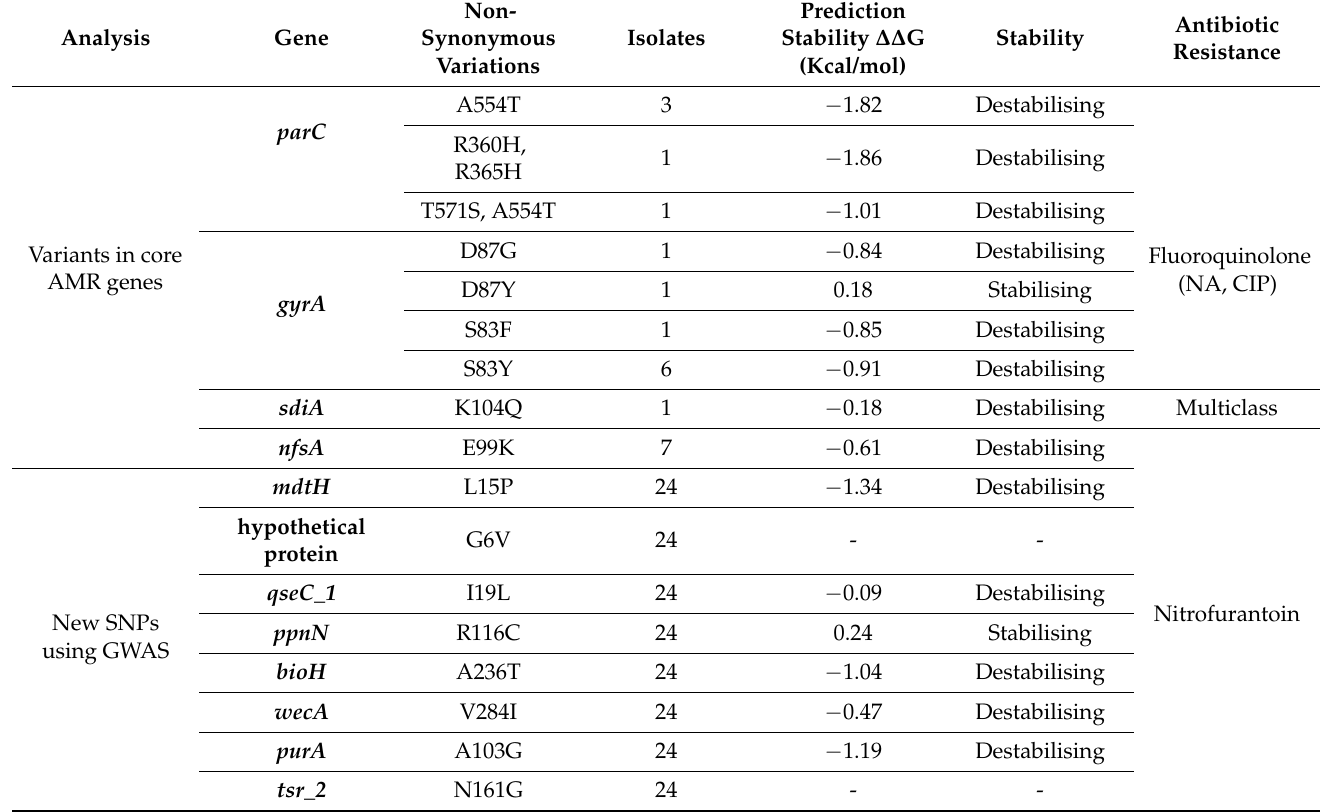
Table 4. Most of the non-synonymous variations for the NA and N resistance are predicted to be destabilising based on ∆∆ G (Kcal/mol)